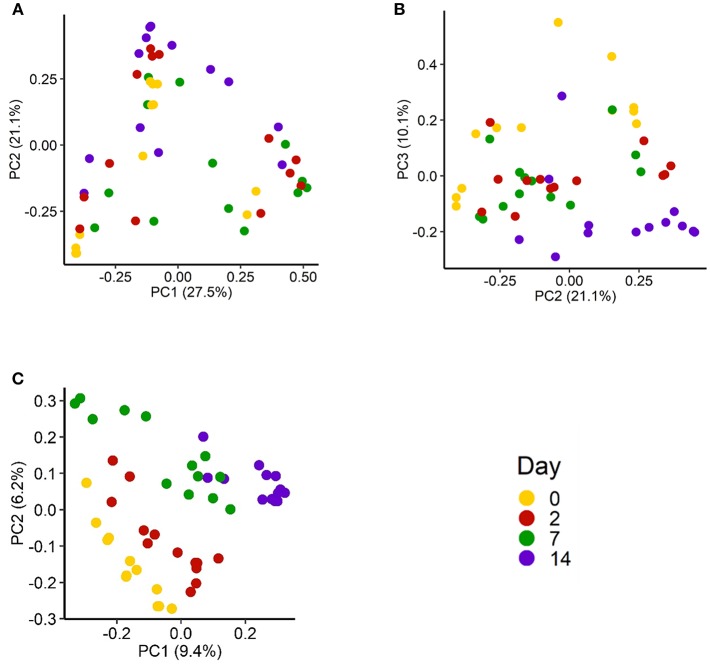
Principal coordinates analysis (PCoA) plot of the Bray-Curtis dissimilarities of the nasopharyngeal microbiota by sampling day for (A) PC1 vs. PC2 and (B) PC2 vs. PC3. (C) PCoA plot of the Jaccard distances of the nasopharyngeal microbiota of cattle (n = 13) by sampling day. The percentage of variation explained by each principal coordinate is indicated on the axes.